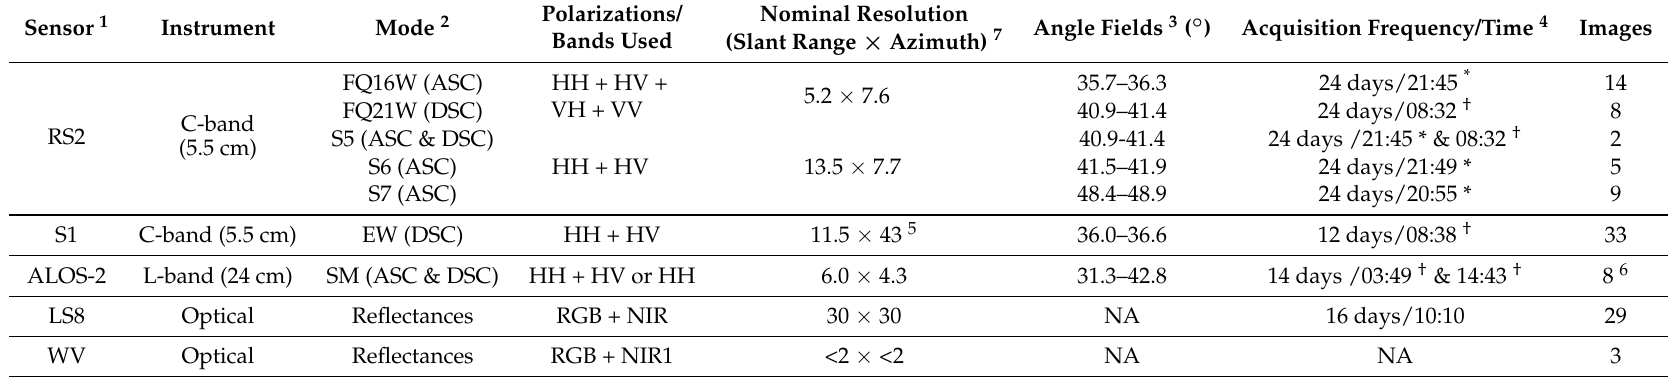
Table 2. Characteristics of available remote sensing data. 1 RS2 = Radarsat-2, S1 = Sentinel-1, LS8 = Landsat-8, WV = WorldView; 2 FQ: Fine Quad, W: Wide, S: Standard, EW: Extra Wide mode, SM: Stripmap, ASC: ascending pass, DSC: descending pass; 3 incidence angles; 4 UTC and approximate times, local time -2 or